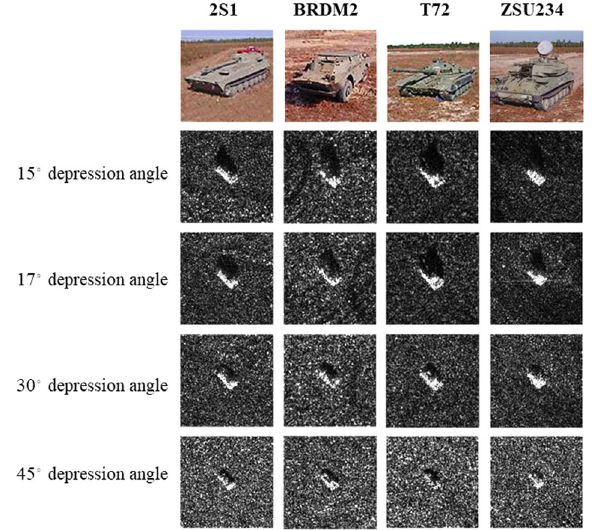
Fig. 5 Optical and SAR images of four classes of targets in the MSTAR